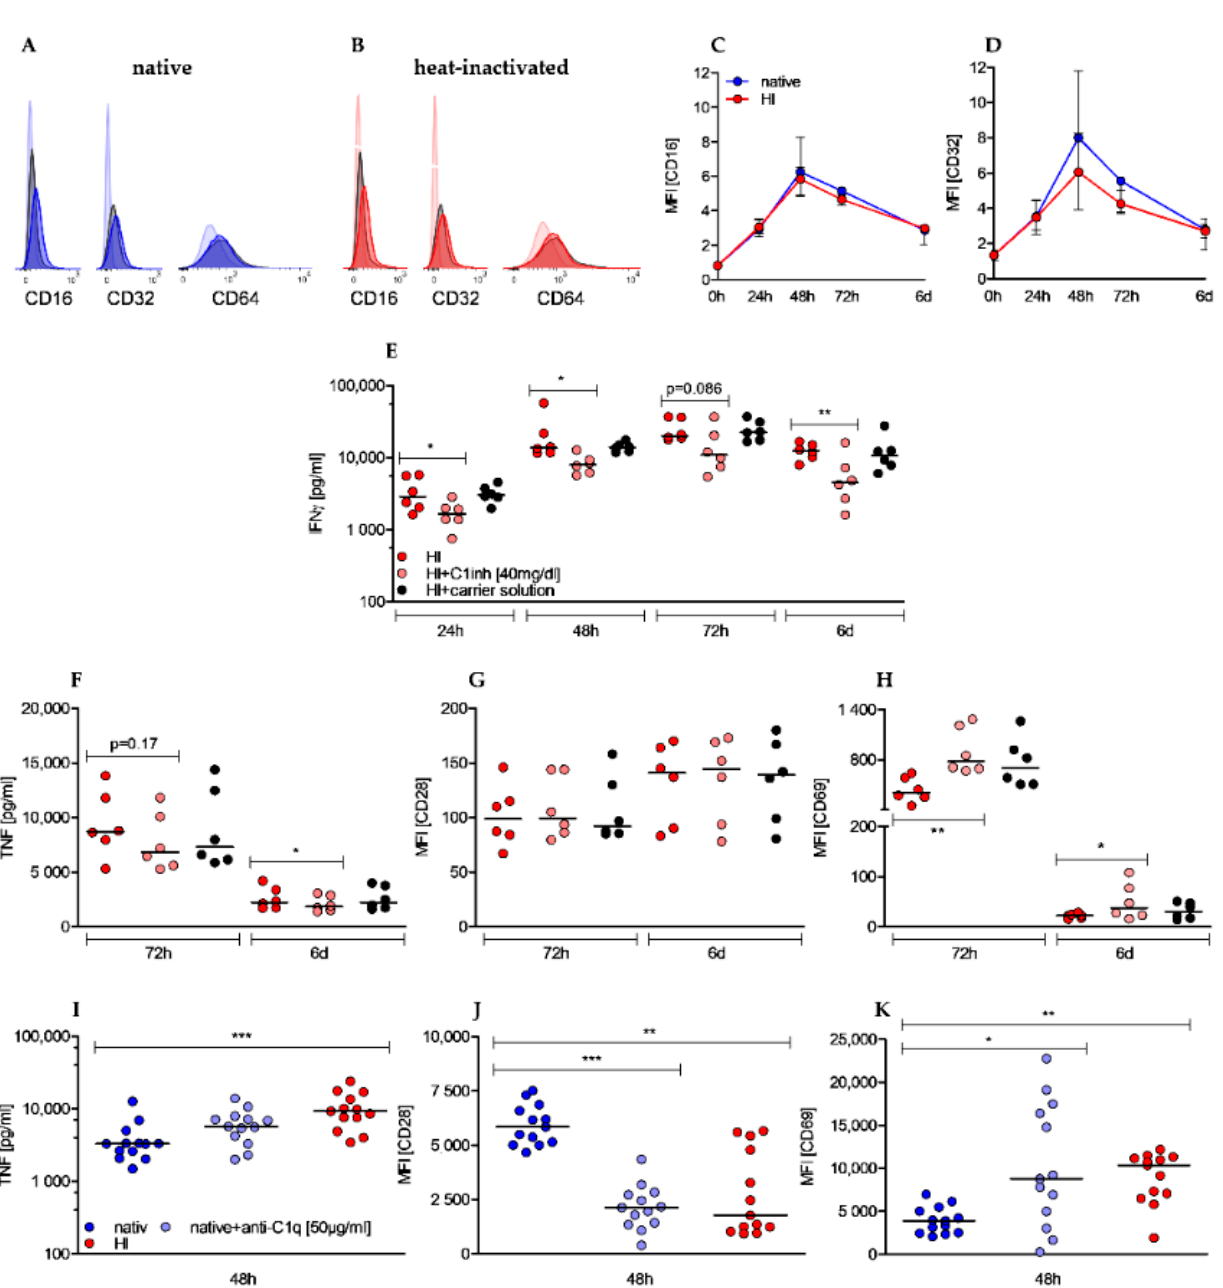
Figure 5. Effects of heat-inactivation are not related to Fc γ receptors II (CD32) and III (CD16) expression but are partially reverted by C1 inhibitor and mimicked by anti-C1q antibody supplementation. ( A , B ) Histogram plots display expression of CD16, CD32, and CD64 (opaque colors) compared to isotype controls (black) and unstained cells (transparent color) in native (A) and HI cultured cells (B) after 48 h of stimulation. One representative experiment is shown. ( C , D ) ∆ MFI (difference of MFI antibody and MFI isotype) of CD16 ( C ) and CD32 ( D ) is depicted in a time-dependent manner. Shown is the median ± interquartile range of n = 4 (24 h/48 h/72 h/6 d) and n = 2 (0 h). ( E – H ) C1 inhibitor was added to T cells cultured with heat inactivated serum. In the presence of C1 inhibitor IFN γ ( E ), TNF ( F ), CD28 ( G ), and CD69 ( H ) were analyzed at indicated time points. (Shown is the median of n = 6, each dot represents one donor, Friedman test, post-hoc Dunn’s, * p < 0.05, ** p < 0.01). ( I – K ) Anti-C1q antibody was added to T cells cultured with native sera. TNF secretion ( I ) was measured by ELISA and CD28 ( J ) and CD69 ( K ) expression was analyzed by flow cytometry at indicated time points. (Shown is the median of n = 13; Friedman test, post-hoc Dunn’s, * p < 0.05 ** p < 0.01; *** p < Additionally, compared to T cells in native sera, expression of costimulatory receptor CD28 was significantly reduced (Figure 5J) and early activation marker CD69 was